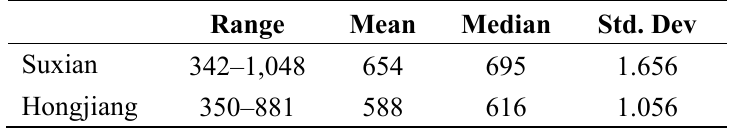
Table 4. Township population mortality of Suxian and Hongjiang in 2010 (per